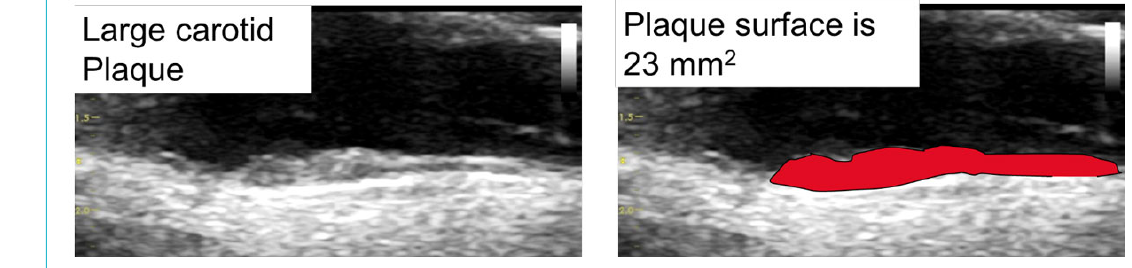
Figure 2: Vendor independent easy to perform measurement of TPA using the surface tool, resulting in an area of 23 mm 2 , which would corre- spond to an vascular age of 34 years in men and to an vascular age of 43 years in women. VA70 corresponds to a total plaque area of 108 mm 2 in men and 66 mm 2 in women, indicating advanced carotid